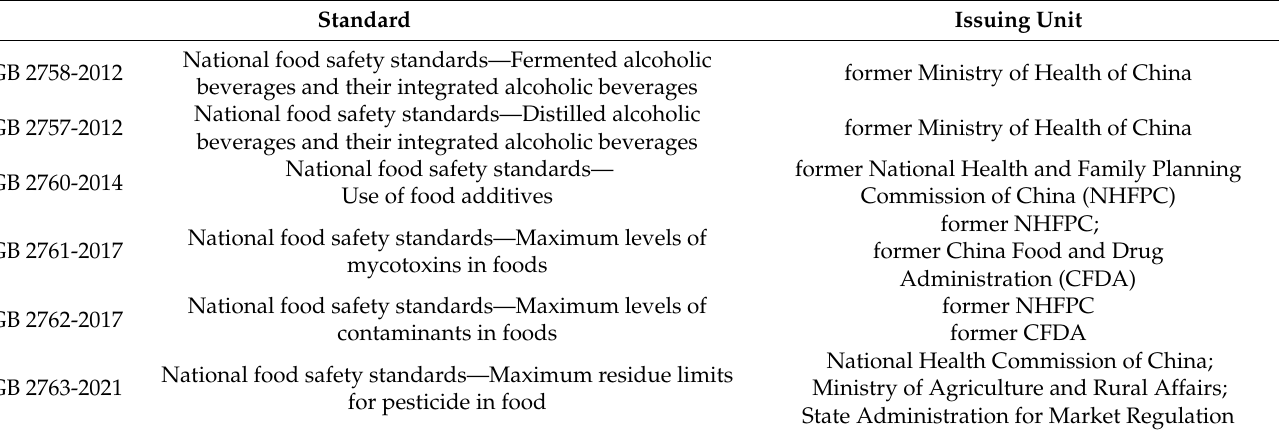
Table 2. National hygienic standards of wine in